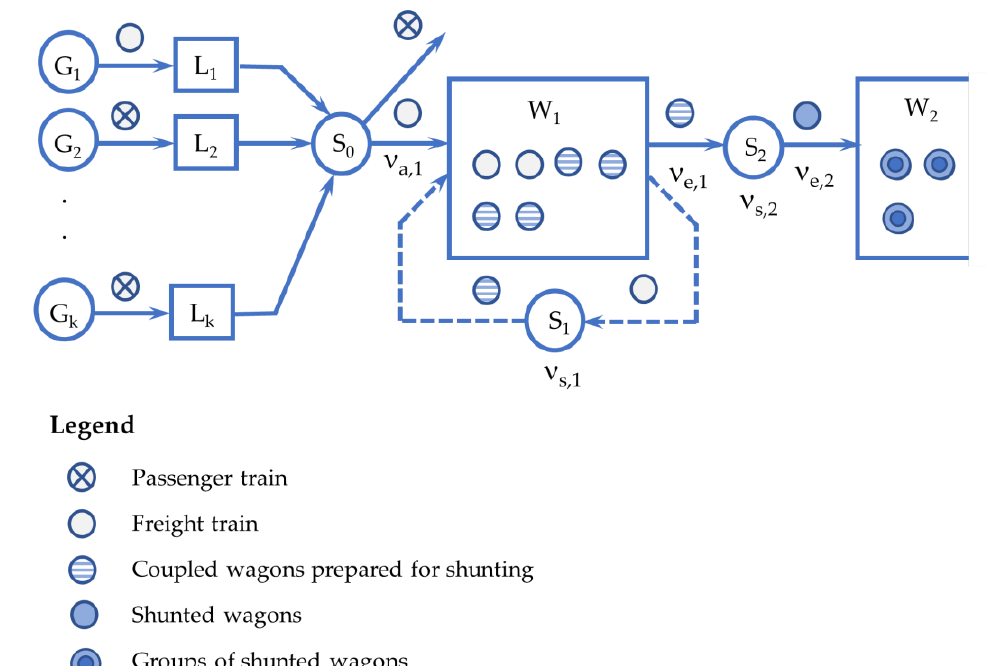
Figure 5. Connected EQSs corresponding to the receiving component of a complex railway station (G 1 , . . . , G k —convergent links in the railway station; L 1 , . . . , L k —traffic signals for access to S 0 , the zone of switches; W 1 , W 2 —tracks of receiving yard, respective shunting yard; S 1 —preparing the arrived freight trains for shunting; S 2 —shunting equipment; ν a , ν s , ν e —coefficients of variation for arrivals, service, dispatching for an EQS).